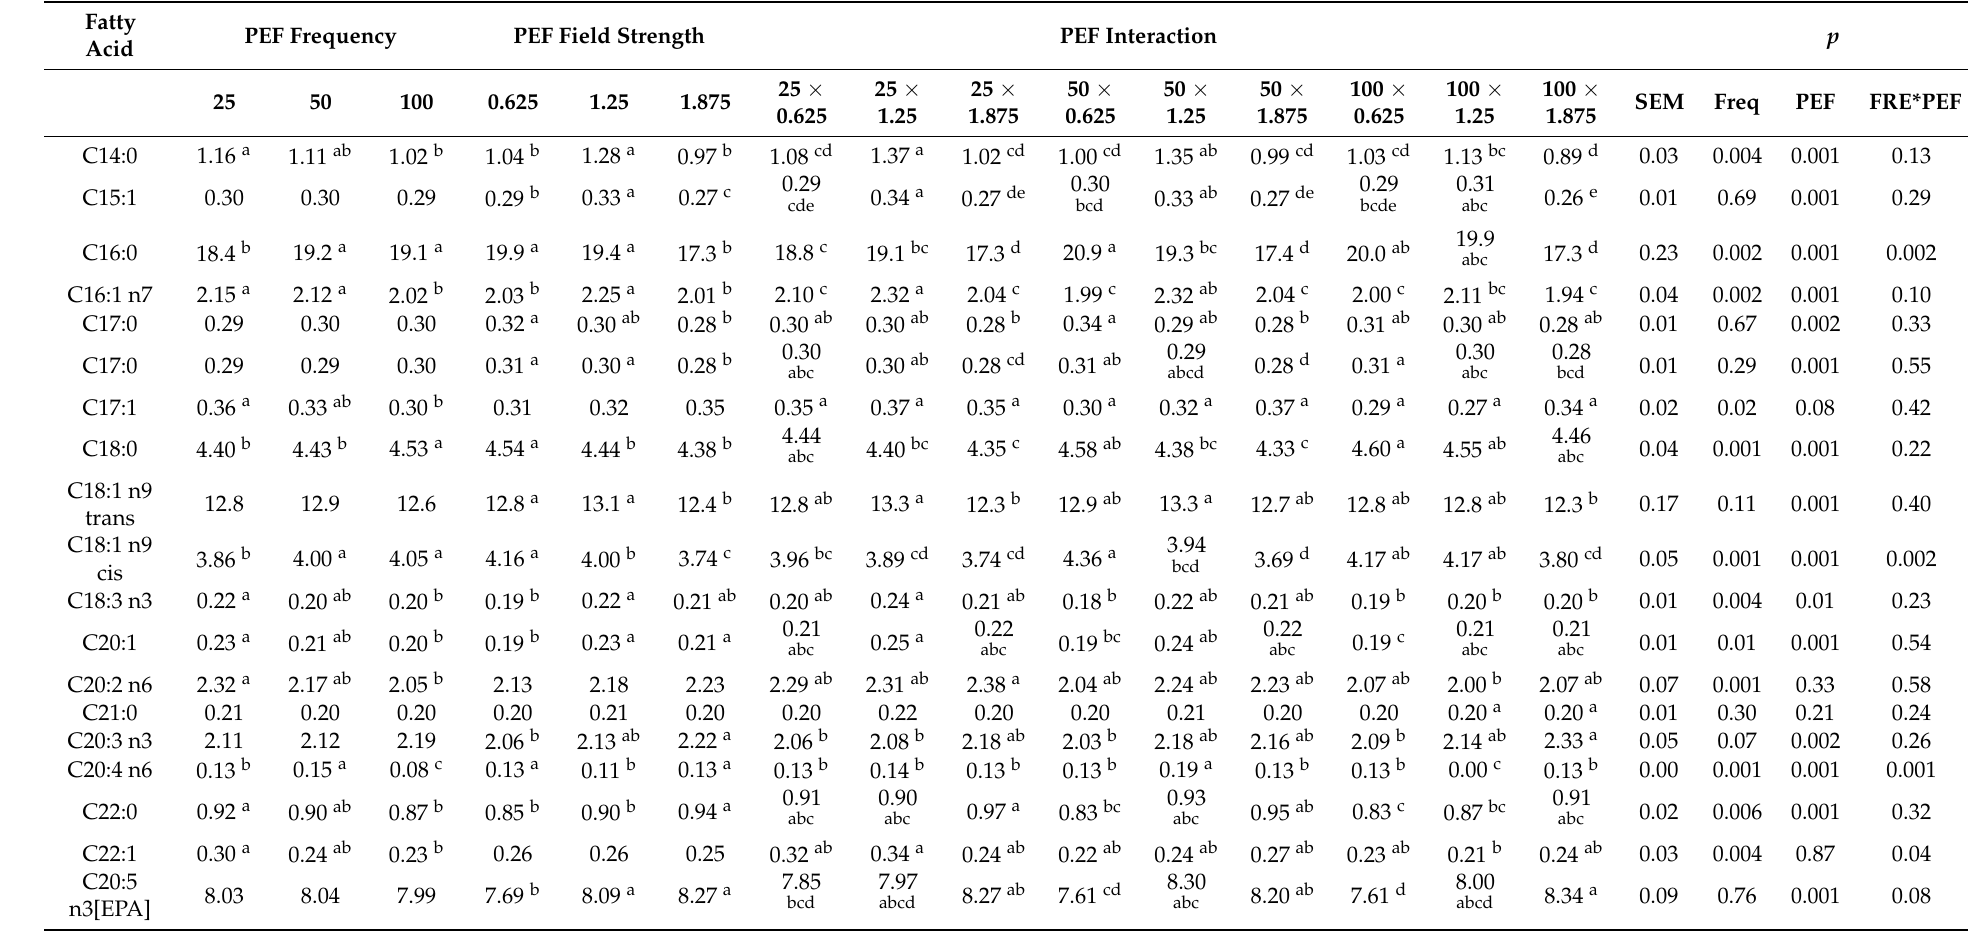
Table 5. Fatty acid composition of total lipid extracted from HMG pre-treated with